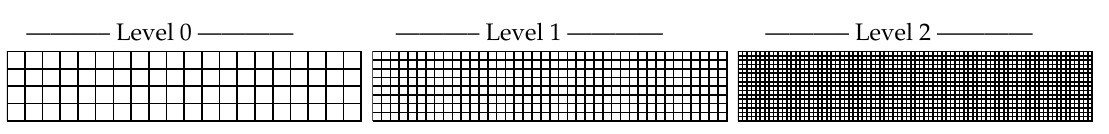
Figure 1. h-refined hierarchy of meshes used for model problem 1.